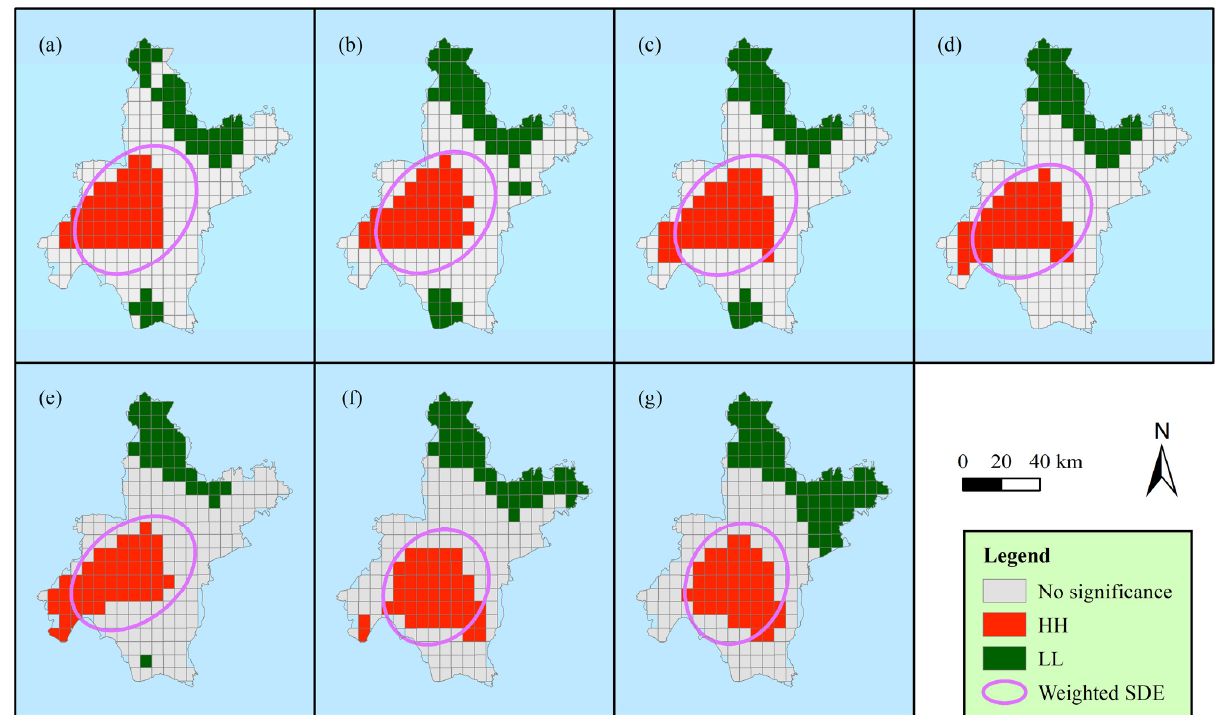
Figure 6. Local spatial pattern of the air temperature at 06:00 (significant level at 0.05). ( a ) 17 July;